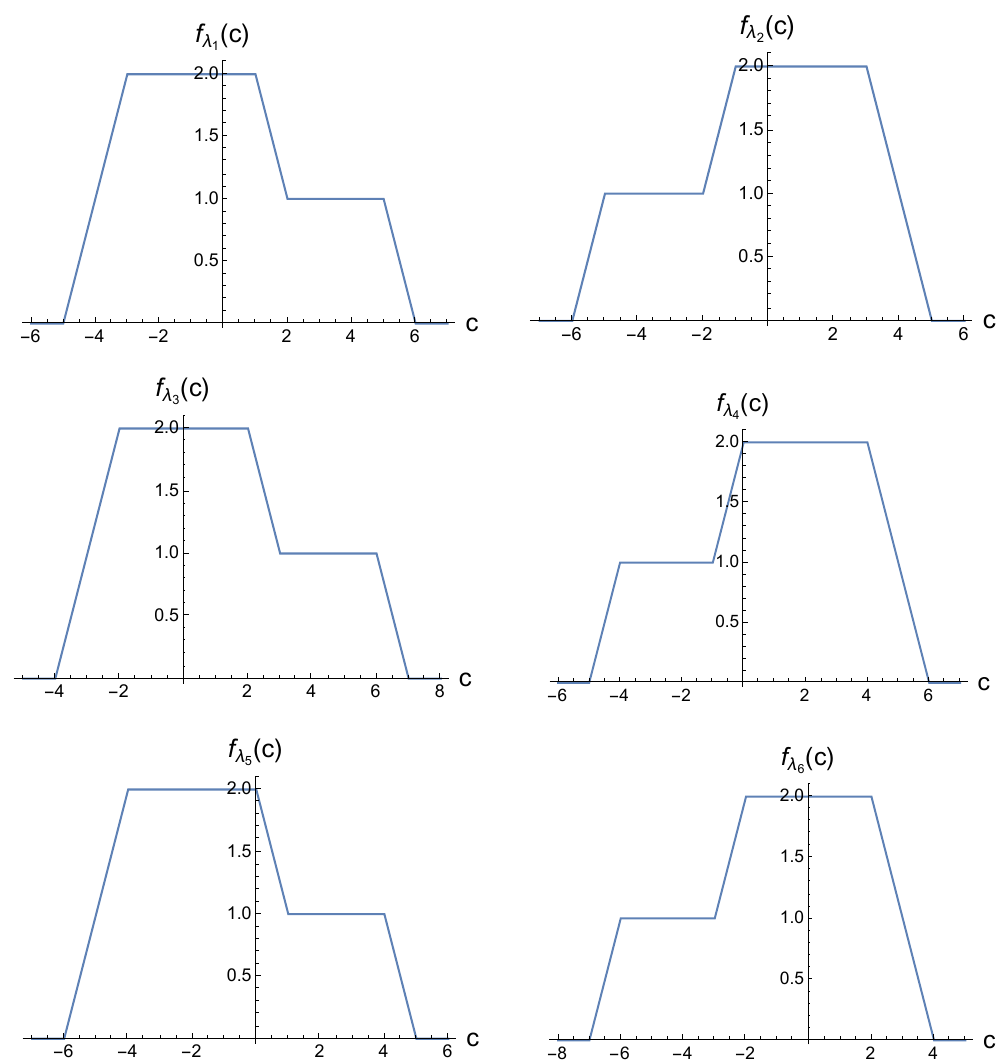
Figure 9 . The CDF plots for the partitions degenerate in